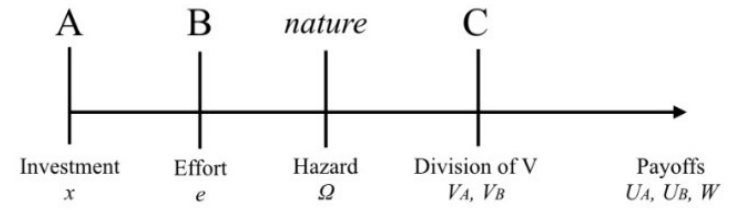
Figure 1. Decision sequence in the influence game.